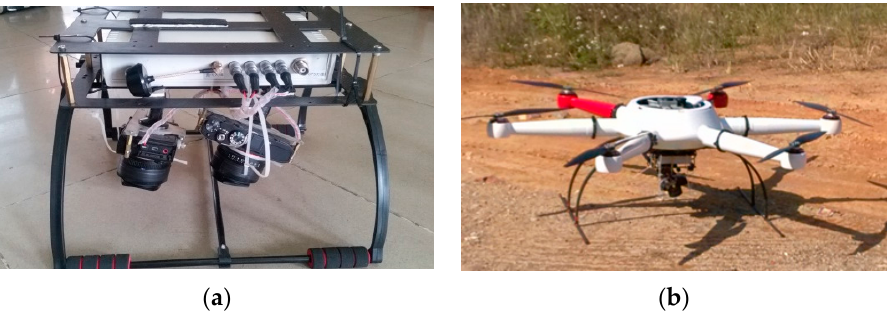
Figure 3. Design and integration of photogrammetric system: ( a ) design of oblique photogrammetric system; and ( b ) integration of oblique photogrammetric system with UAV platform.